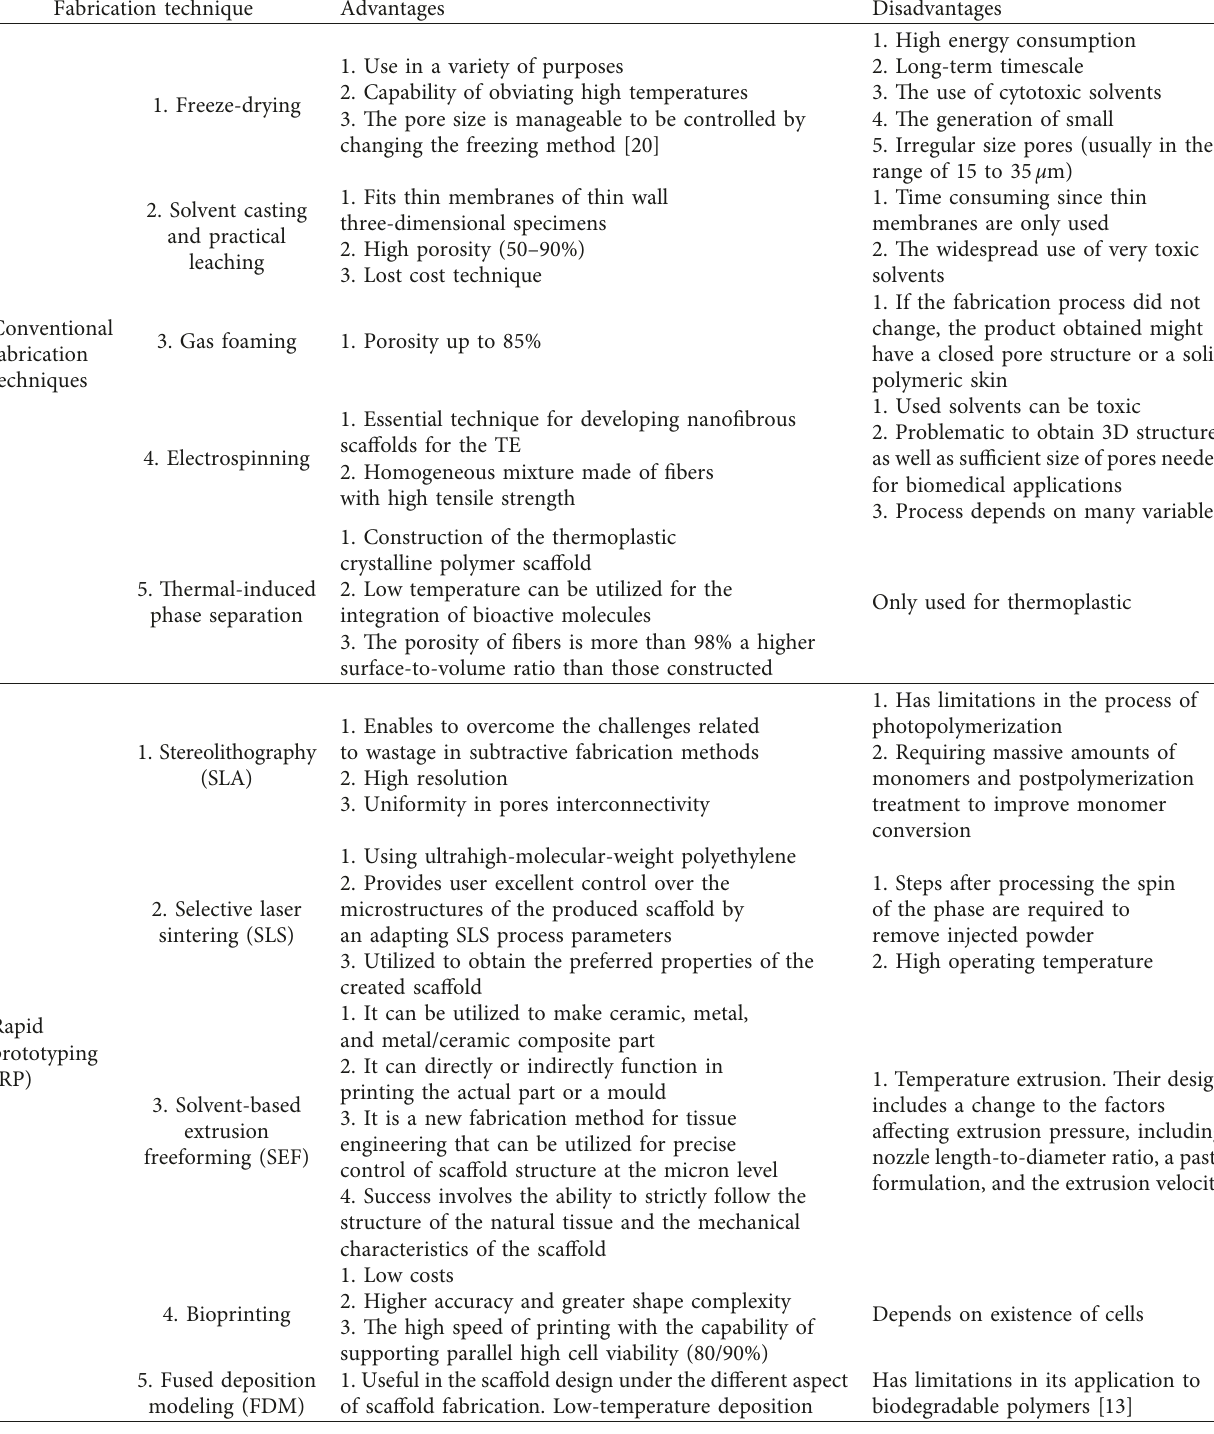
Table 1: Classification of the scaffold fabrication